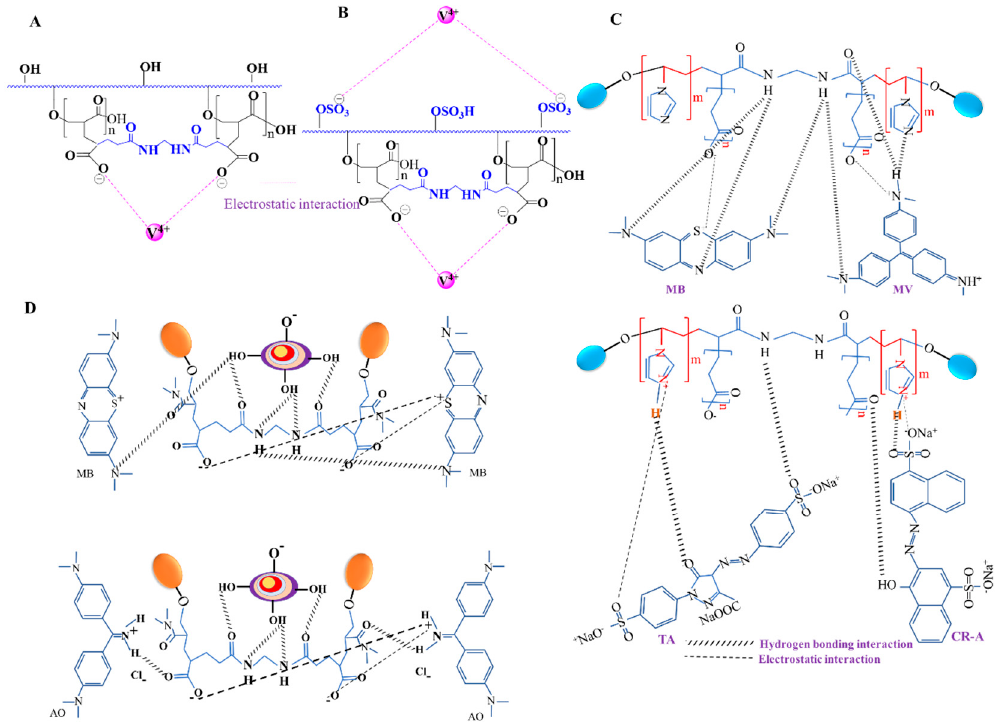
Figure 8. Suggested mechanisms for the interactions between the vanadium (IV) ion and ( A ) gum katira-crosslinked poly(acrylic acid), and ( B ) sulfated gum katira − crosslinked poly (acrylic acid) hydrogel. Reprinted/adapted with permission from [15]. ( C ) Possible absorption mechanism for cationic and anionic dye removal from aqueous solutions. Reprinted/adapted with permission from [13]. ( D ) Putative mechanism of dye removal from aqueous solutions. Reprinted/adapted with permission from [26].